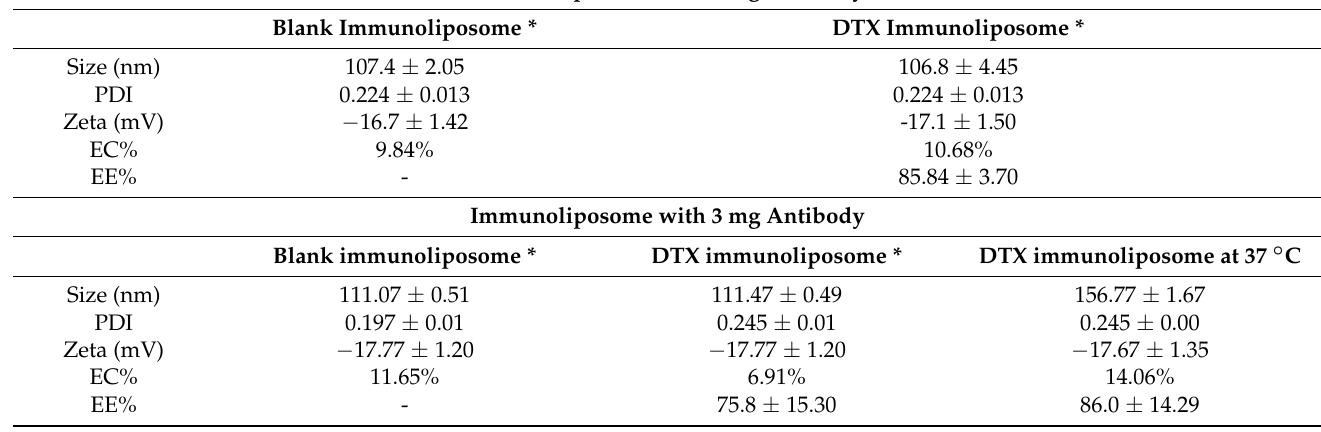
Table 4. Physicochemical characterization of immunoliposome formulations prepared by direct